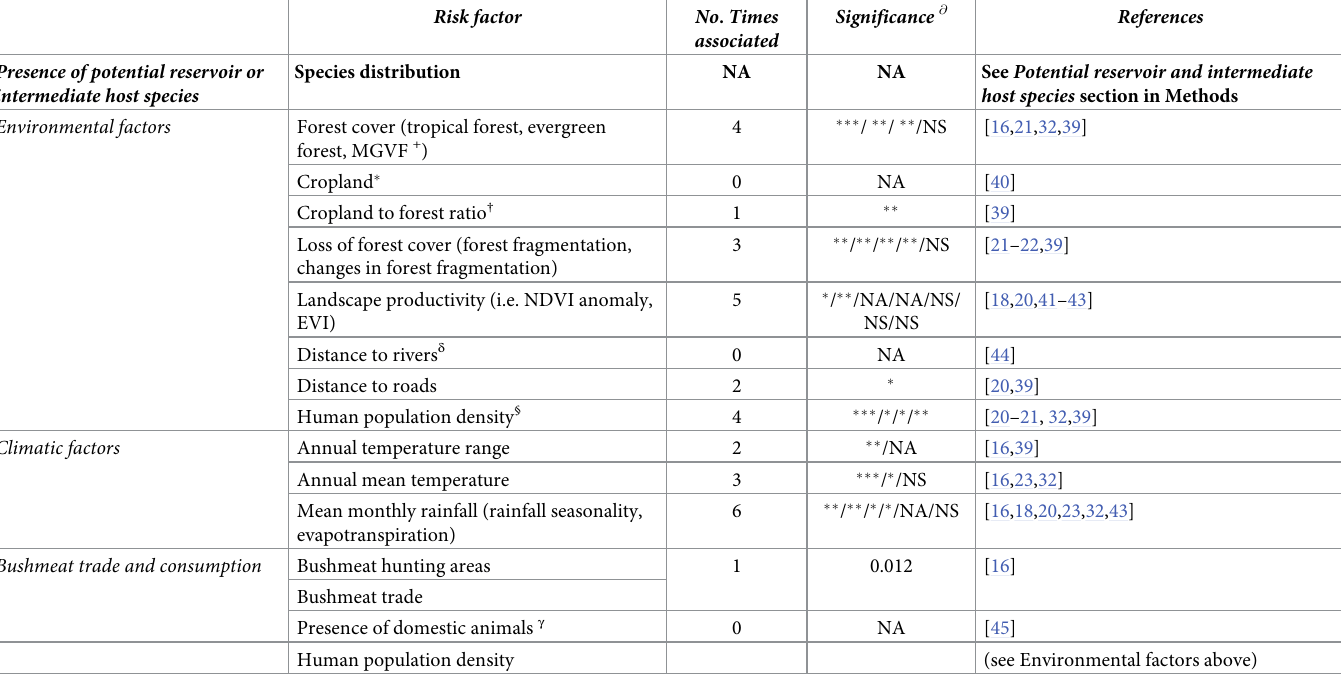
Table 1. Factors associated to the risk of Ebolavirus spillover used in the GIS-MCE. Similar factors (in parenthesis) were considered as one factor for the classification. Some studies did not provide a significance value for the factors (NA). Significance of the risk factor is shown as NS: non-significant / � : p < 0.05 or � 33% of